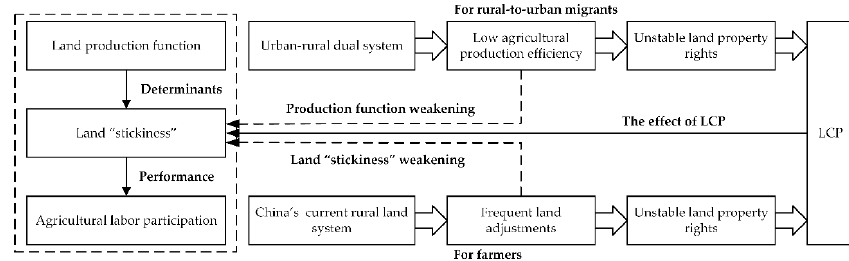
Figure 1. Analytical framework for land “stickiness”.